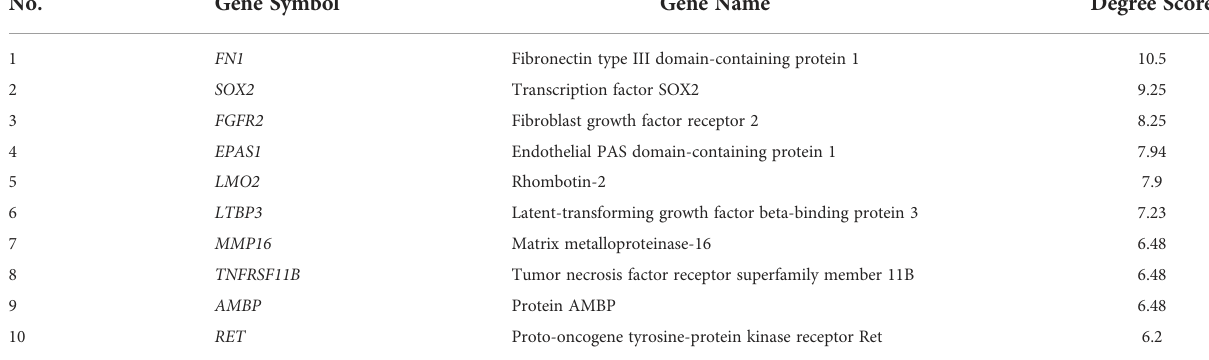
TABLE 3 Top 10 hub genes based on degree score.